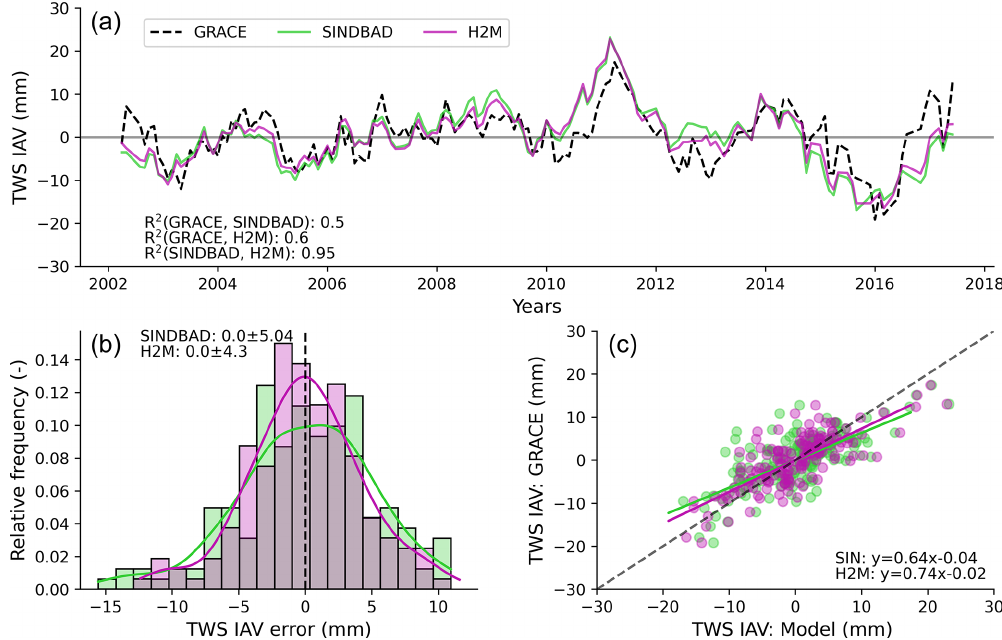
Figure B19. Same as Fig. 2 but using MSWEP instead of GPCP1dd for the precipitation forcing.